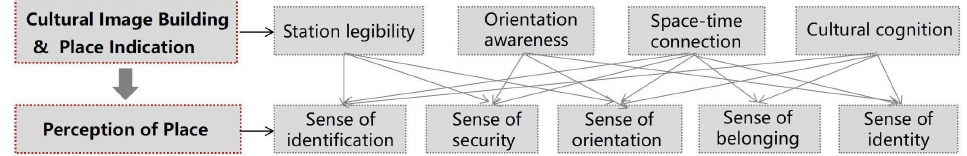
Figure 2. Understanding ”image” through